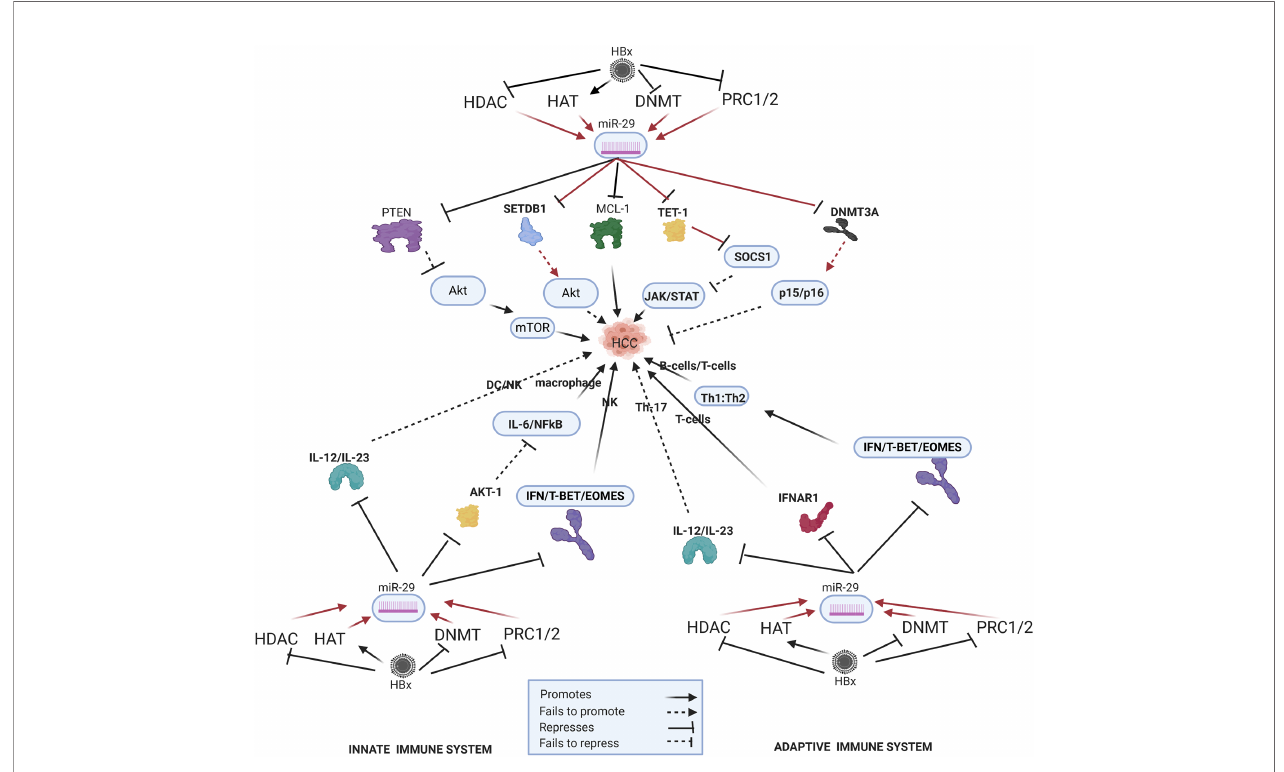
FIGURE 3 | Epi-miR-29 in HBV-HCC and immune pathways. HDAC-Histone deacetylation, HAT-histone acetylation, DNMT-DNA methylation, PRC1/2- Polycomb Repressive Complex, SETDB1-SET Domain Bifurcated Histone Lysine Methyltransferase, TET1-Ten-eleven translocation methylcytosine dioxygenase 1 (pathways in dark red involve identi fi ed direct upstream or downstream epigenetic proteins/enzymes). HBx protein can downregulate or initiate HDAC/HAT/ DNMT/HMT to upregulate miR-29 modulation in various HBV-HCC pathways including AKT/MTOR, TP53, and JAK/STAT to in fl uence HCC pathogenesis. HBx epigenetically upregulated miR-29 also regulates macrophage and DC/NK expression in the innate immune system, as well as T-cell and B-cell expression in the adaptive immune